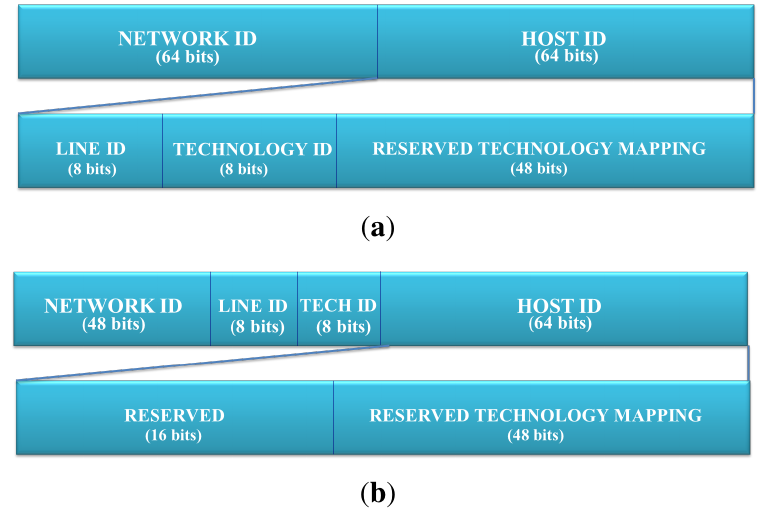
Figure 1. IPv6 address format in the IPv6 addressing proxy. ( a ) Addressing functionality in application level; ( b ) Addressing functionality within